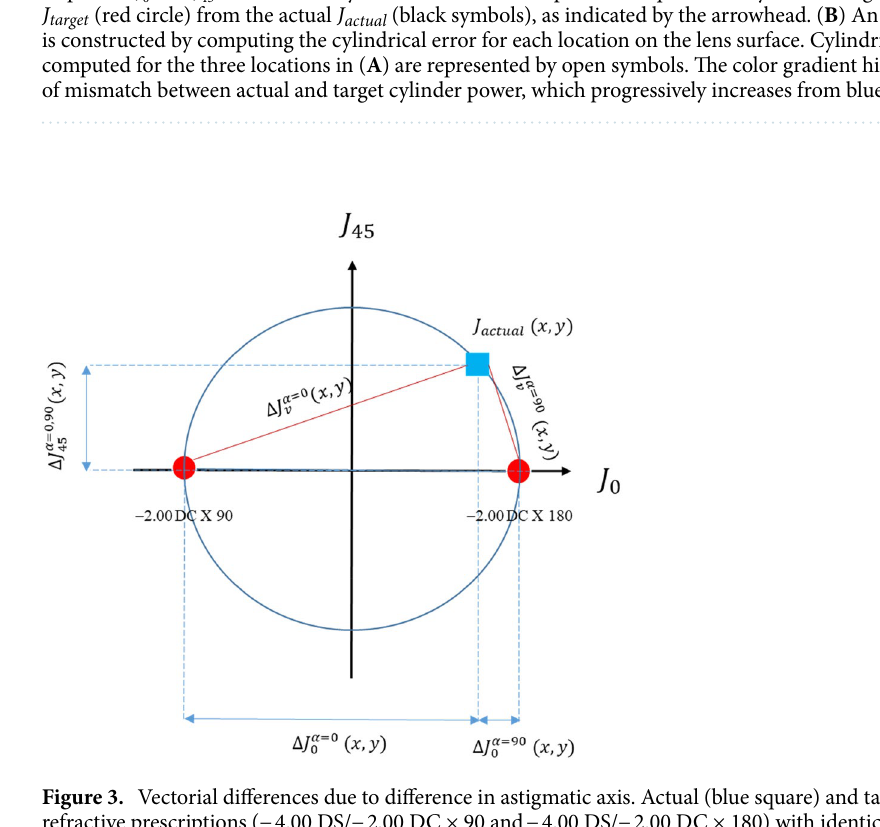
arrays were used to calculate two-dimensional refractive maps of spherical and cylindrical powers. The software required the input of the following lens parameters for the calculation of the refractive power map: lens refractive index (provided by the lens manufacturer), center thickness (measured by a lens gauge), and front surface radius (measured by a lens clock). The locations of the two standard laser-engraved symbols of the PAL were identified with standard procedures and marked by a fine-tip marker. The lens front was placed face down according to the